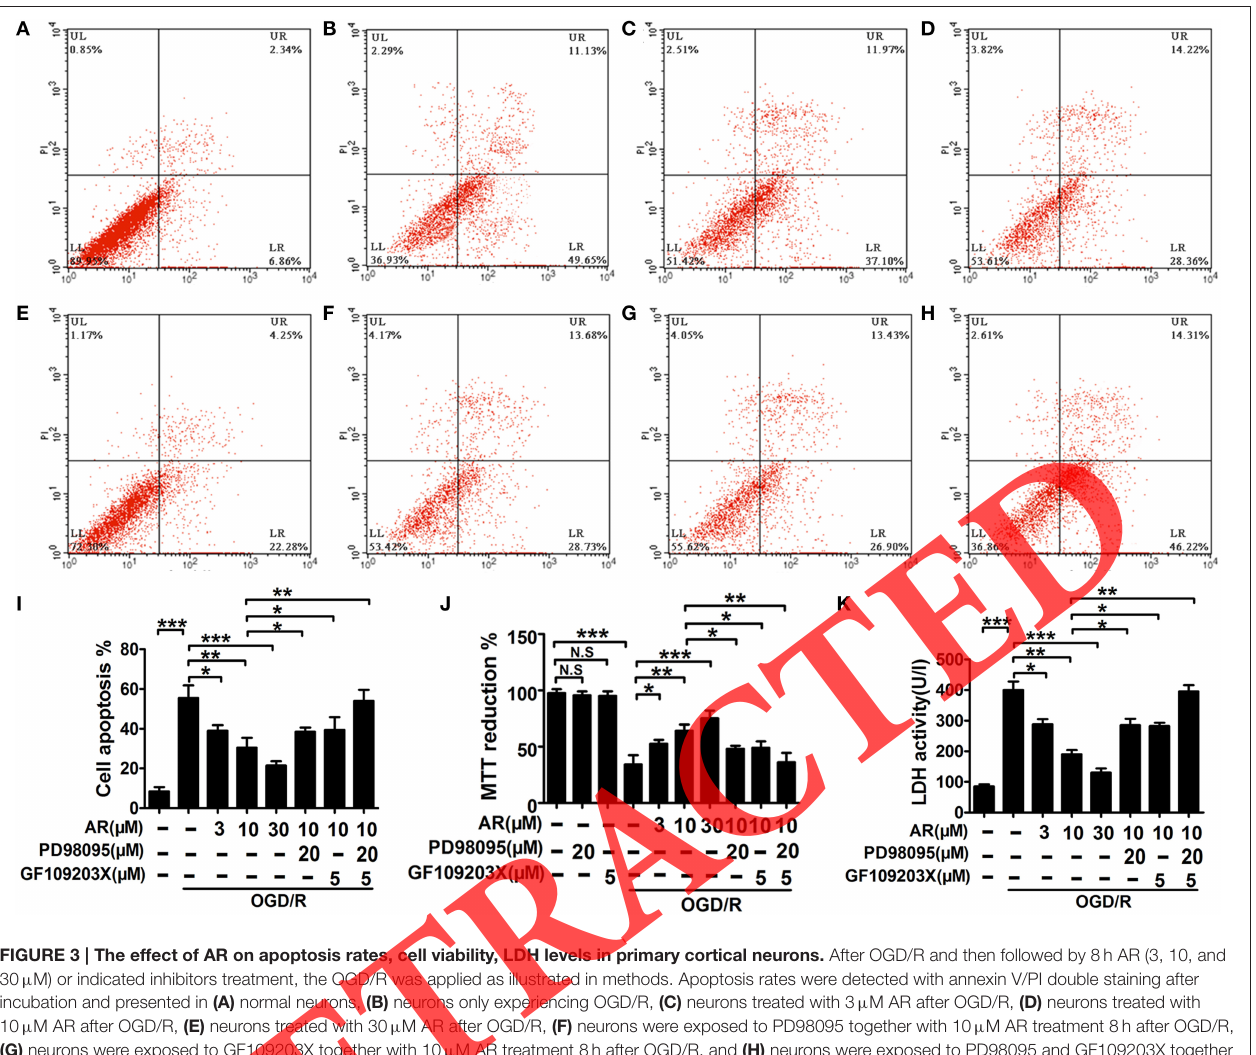
FIGURE 3 | The effect of AR on apoptosis rates, cell viability, LDH levels in primary cortical neurons. After OGD/R and then followed by 8h AR (3, 10, and 30 µ M) or indicated inhibitors treatment, the OGD/R was applied as illustrated in methods. Apoptosis rates were detected with annexin V/PI double staining after incubation and presented in (A) normal neurons, (B) neurons only experiencing OGD/R, (C) neurons treated with 3 µ M AR after OGD/R, (D) neurons treated with 10 µ M AR after OGD/R, (E) neurons treated with 30 µ M AR after OGD/R, (F) neurons were exposed to PD98095 together with 10 µ M AR treatment 8h after OGD/R, (G) neurons were exposed to GF109203X together with 10 µ M AR treatment 8h after OGD/R, and (H) neurons were exposed to PD98095 and GF109203X together with 10 µ M AR treatment 8h after OGD/R. (I) Quantification of apoptotic rates. (J) Cell viability was analyzed by MTT assay and data were described as % of normal neurons. (K) Neurons injury was determined by LDH activity assay. Results mentioned-above were mean ± SD for 4 individual experiments which, for each condition, were performed in quadruplicate. * P < 0.05 ; ** P < 0.01 ; *** P < 0.001 . N.S, no